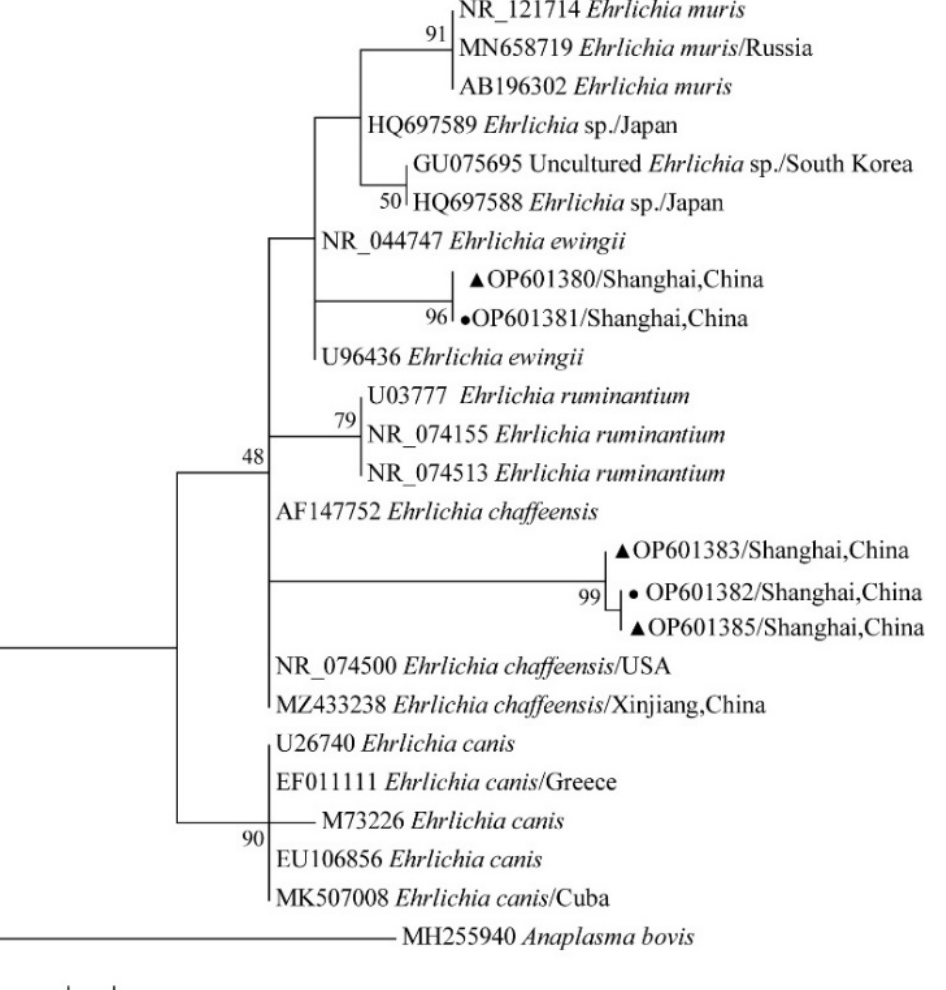
14 of 23 Figure 11. Phylogenetic tree of Coxiella spp. in ticks based on partial 16S rDNA gene sequence sim ‐ ilarity. The sequence from H. flava obtained in this study is indicated with a black triangle, and the sequence from H. longicornis obtained in this study is indicated with black dots. Sequences were